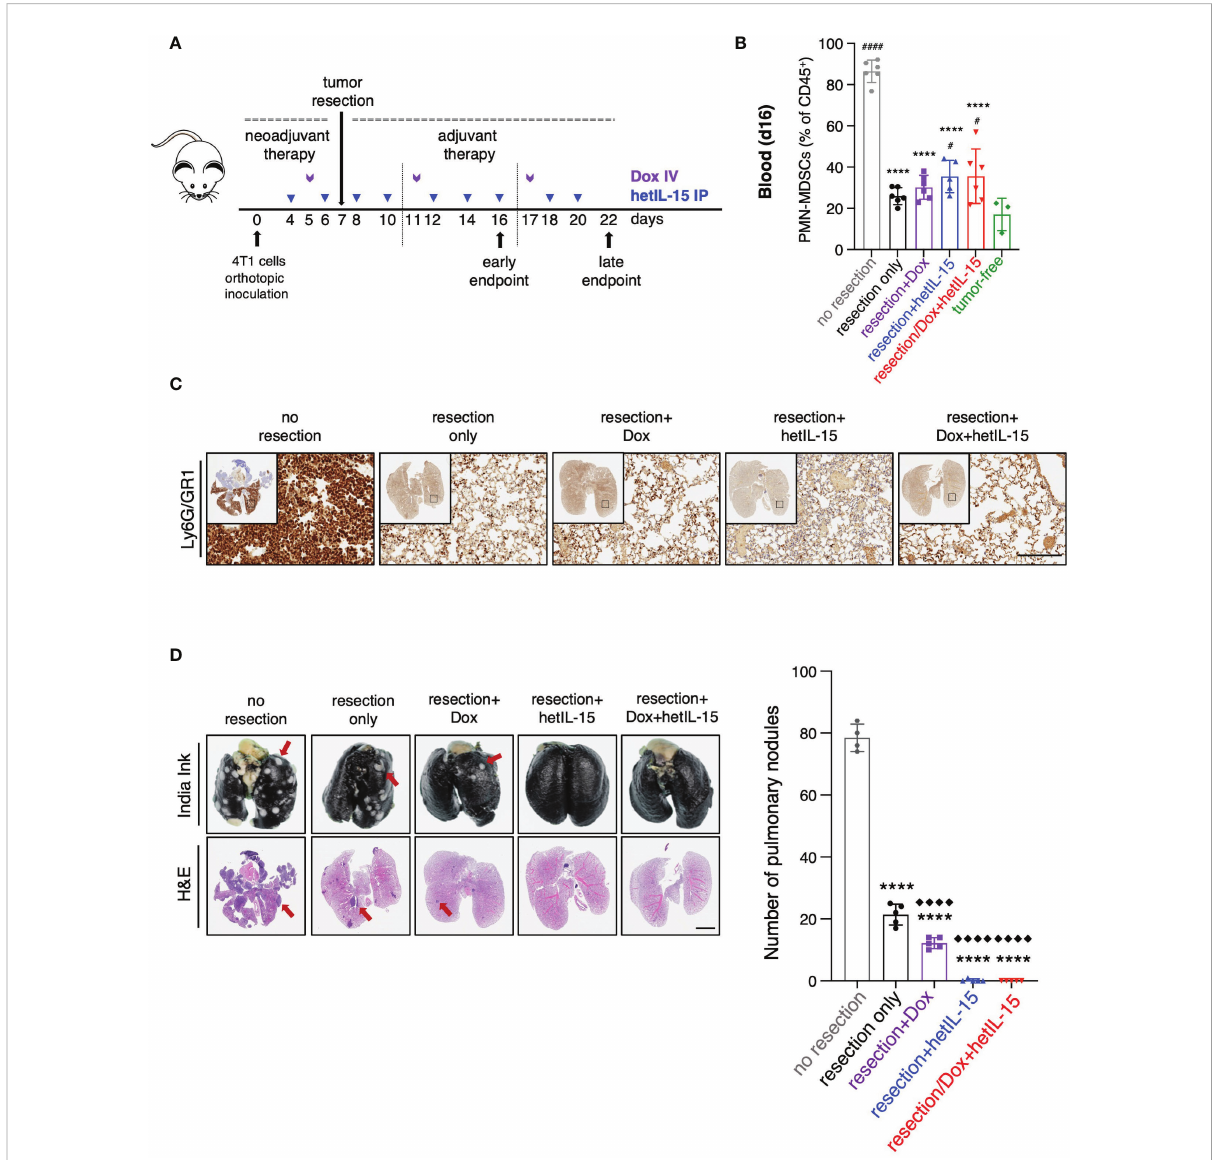
FIGURE 5 Tumor resection reduces PMN-MDSCs and together with hetIL-15, either alone or in combination with doxorubicin, eradicates metastatic disease. (A) Cartoon showing the experimental design with the time of tumor resection and the treatments in neoadjuvant and adjuvant setting. 0.35-1x10 6 4T1 cells were orthotopically inoculated in Balb/c mice and tumors were resected one week later. The mice randomized in fi ve groups: (i) no resection, (ii) resection only, (iii) resection+Dox, (iv) resection+hetIL-15 and (v) resection+combinatorial treatment. Treatment started 3 days before surgery with hetIL-15 (3 m g/mouse IP, blue arrows) every other day, followed by doxorubicin (5mg/kg IV, purple arrows) once per week. Treatment endpoints were day 16 (early) or day 22 (late). (B) PMN-MDSCs frequencies in blood of each group on day 16. Data obtained from tumor-free mice are also included (n=3). Data are from one experiment; bars shown the mean ± SD for each group (n=5-6). Asterisks show the signi fi cance of difference from the non-resected group and hashtags from the tumor-free group # p < 0.05, **** or #### p < 0.0001. (C) Representative IHC images of Ly6G/GR1-stained lungs from one mouse in each group on day 22. Scale bar, 200 m m. Similar results were observed in two independent experiments. (D) Representative images from India ink- and H&E-stained lungs (left panels) and number of white tumor nodules (from India ink staining evaluation) in lungs (right panel) are shown as mean ± SD for each group (n=4-5). Results were obtained from two independent experiments. Scale bar, 4mm. Statistical analysis was done by one-way ANOVA and Tukey ’ s or Dunette ’ s multiple comparisons test. Asterisks show the signi fi cance of difference from the non-resected group and rhombuses from the resection-only group, **** or ◆◆◆◆ p < 0.0001. SD, standard deviation. Image Credit: